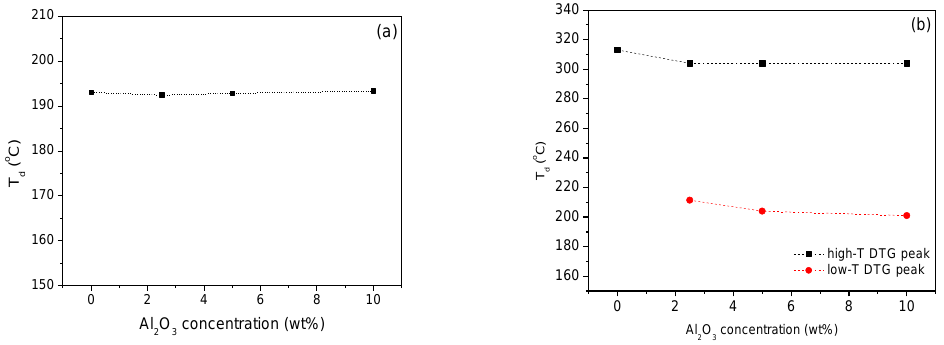
Figure 6. Decomposition temperature of ( a ) TBA-Br and ( b ) TBA-PF 6 with Al 2 O 3 additive concentration.